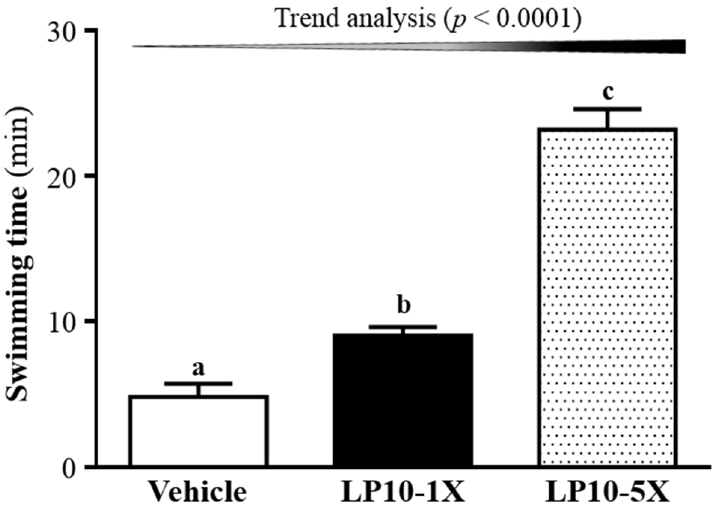
Figure 1. Effects of LP10 ( Lactobacillus plantarum TWK10) supplementation for six weeks on forelimb grip strength. Mice were pretreated with vehicle, LP10 ‐ 1X, or LP10 ‐ 5X for six weeks, and then forelimb grip strength was tested. Data are mean ± SEM, 8 mice/group, by one ‐ way ANOVA. Different letters (a, b) indicate a significant difference at p < 0.05.